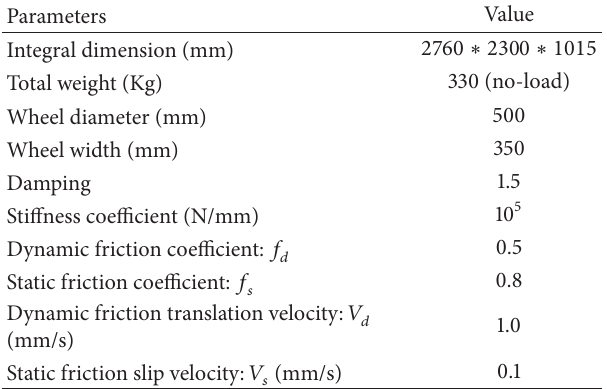
Table 1: Simulation parameters of the rocker-bogie